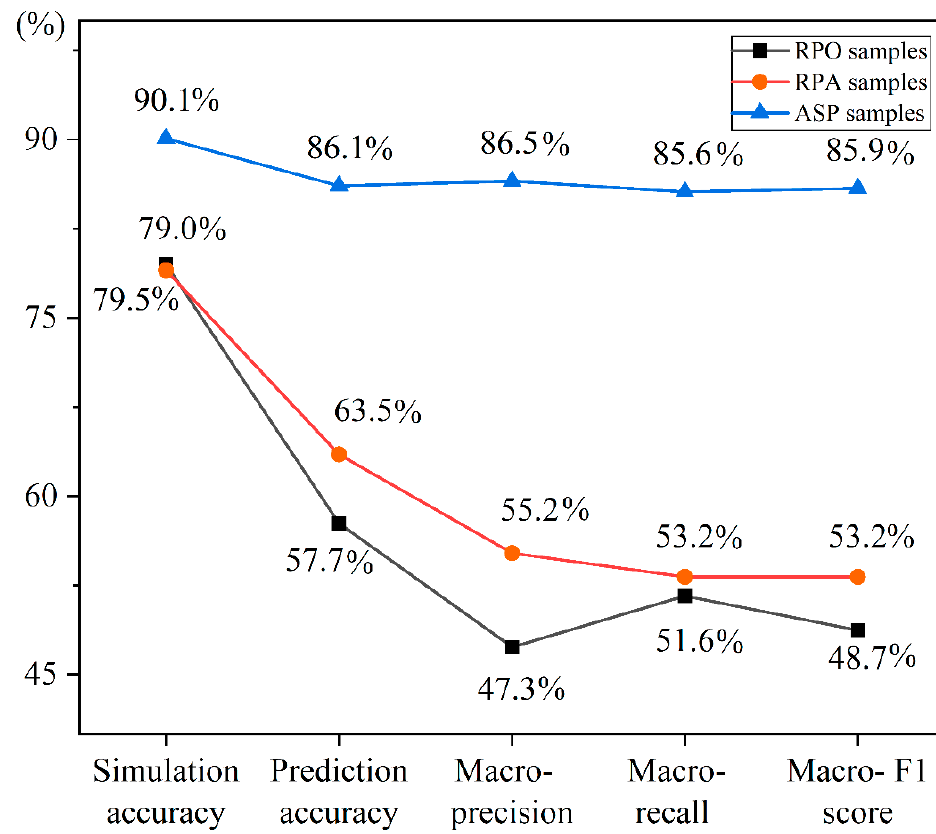
Figure 8. Comparison of the performance of the RPO-RF, RPA-RF, and ASP-RF models.